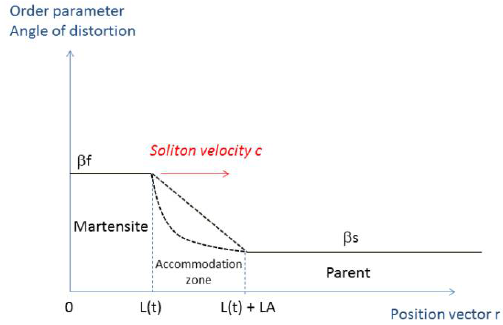
Figure 35. Ramp function for the angular parameter β of the lattice distortion transformation D ( β